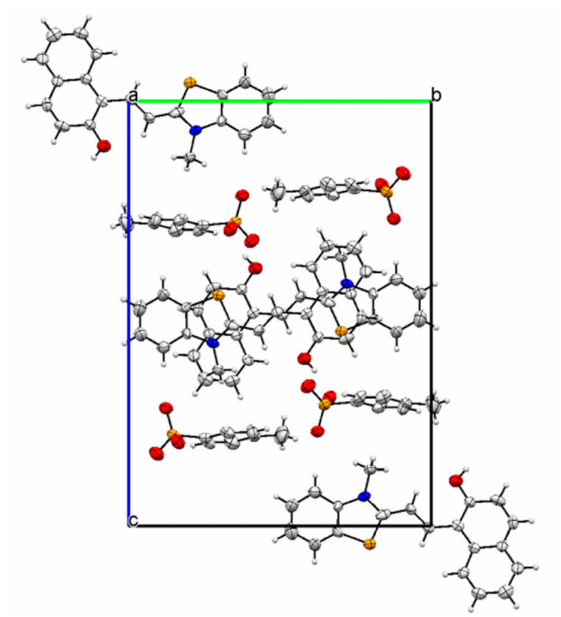
Figure 2. The crystal packing diagram of 1 viewed along axis a with displacement ellipsoid at 50% probability.